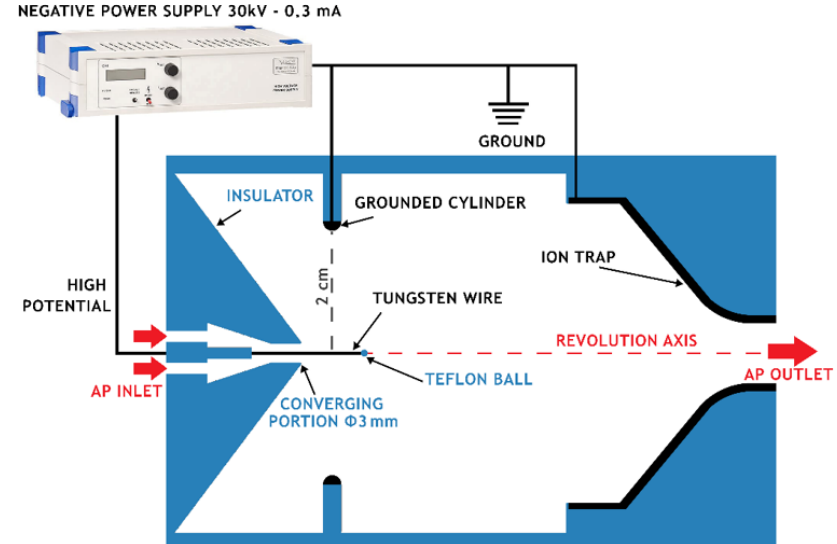
Figure 3. Geometry of the home-made AP charger based on Unger et al. (2004).